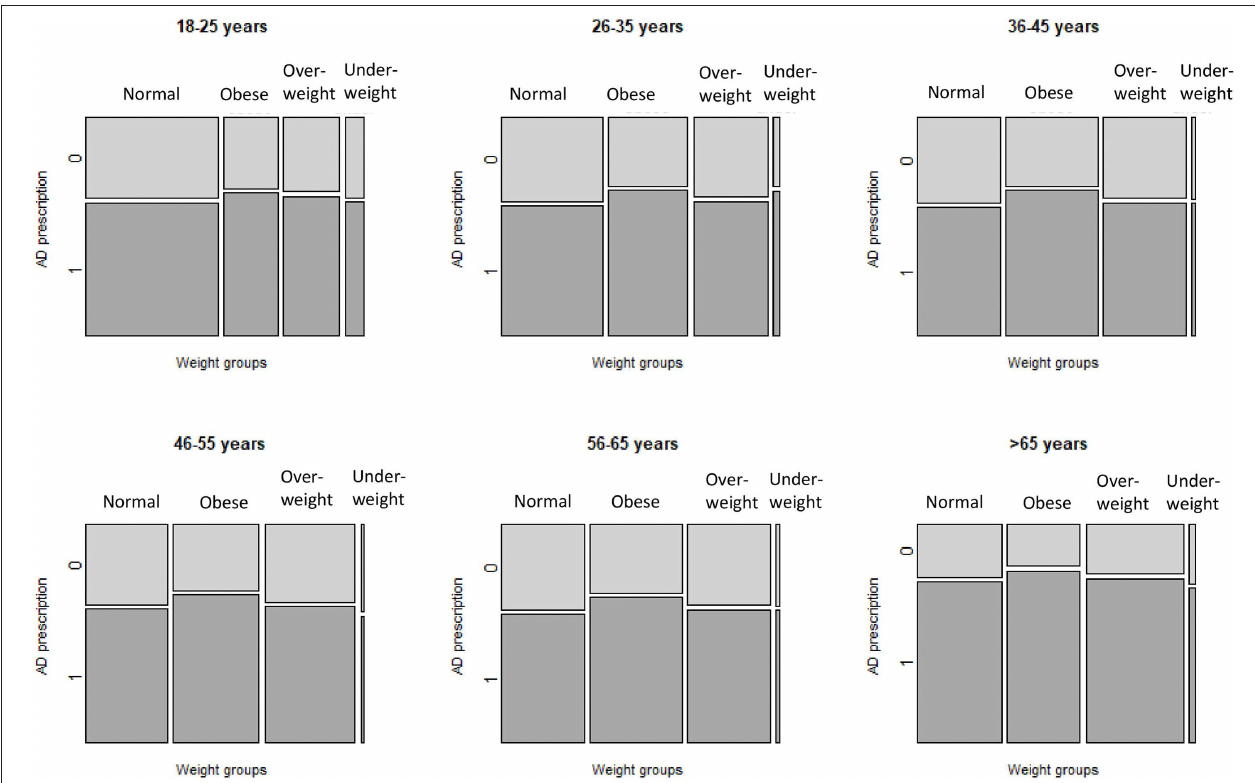
FIGURE 3 | Prevalence of AD prescribing, according to weight category and age group. AD, antidepressant medications. Each mosaic plot represents an age group. The bars (Normal, Obese, Overweight, Underweight) represent weight categories; thickness of the bars represent a proportion of patients in each weight category. Dark tiles represent proportions of patients with AD prescriptions (“1”), light tiles—proportions of patients without AD prescriptions (“0”) in each weight category.